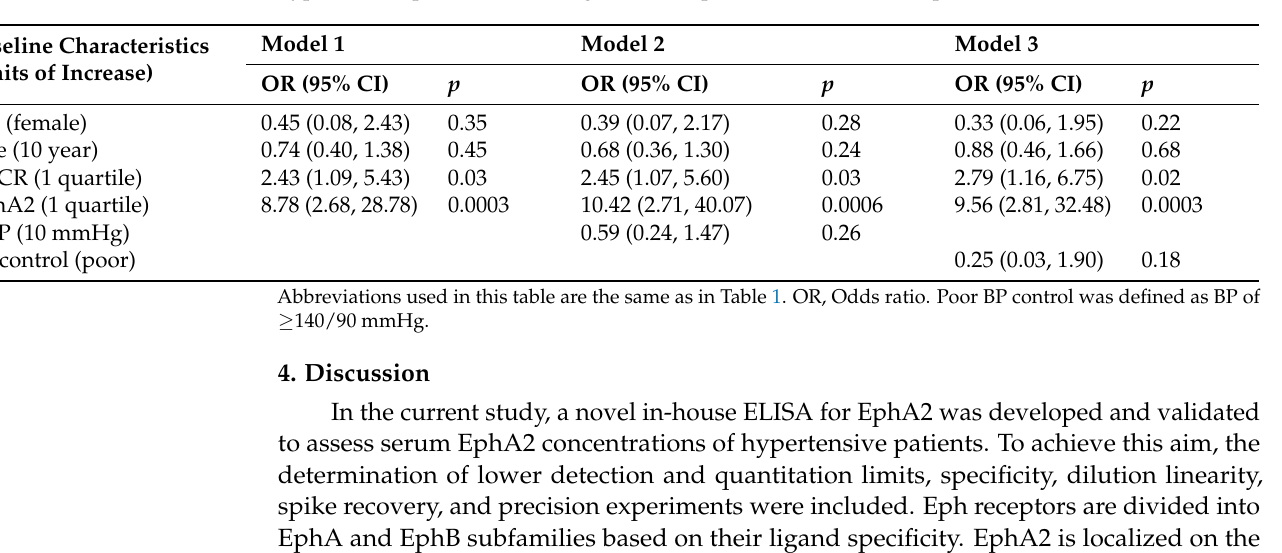
Table 5. Multivariate logistic regression model of risk for lower eGFR <30 mL/min/1.73 m 2 in hypertensive patients according to clinical predictors and serum